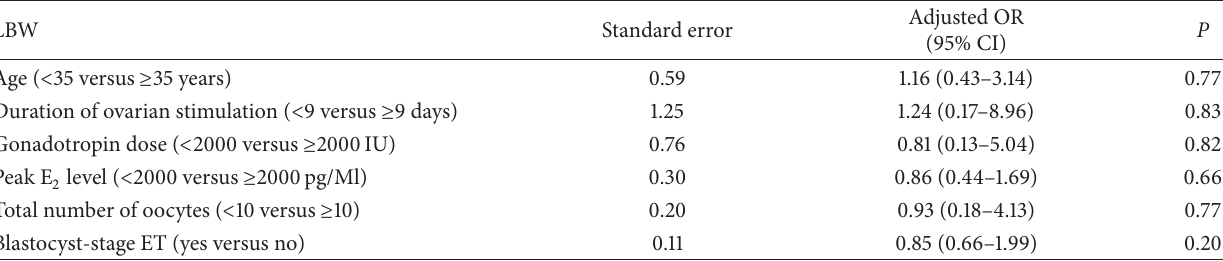
Table 5: Low birth weight and multiple logistic regression to account for confounding variables.